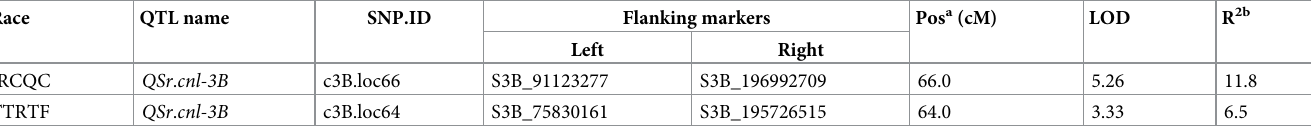
Table 4. QTL identified using composite interval mapping for seedling response to races JRCQC and